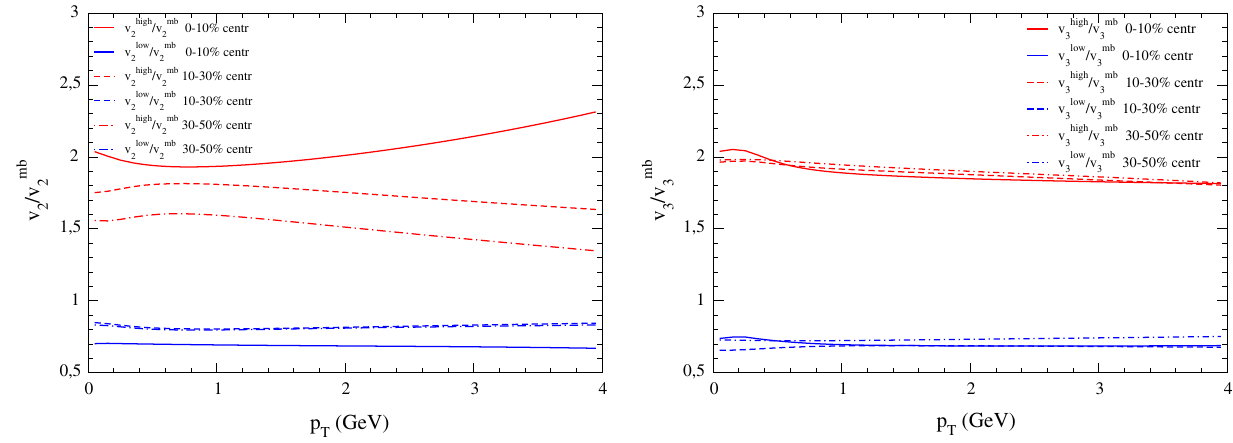
Fig. 6 Ratio of the charged-pion elliptic (left) and triangular (right) flow of high/low-eccentricity events over the minimum-bias ones within the same centrality class. Results of our hydrodynamic modelling can be compared to ALICE data from Ref. [28] Table 1 The ratios Centrality (cid:6) (cid:7) 2 (cid:7) high / (cid:6) (cid:7) 2 (cid:7) mb (cid:6) (cid:7) 2 (cid:7) low / (cid:6) (cid:7) 2 (cid:7) mb (cid:6) (cid:7) 3 (cid:7) high / (cid:6) (cid:7) 3 (cid:7) mb (cid:6) (cid:7) 3 (cid:7) low / (cid:6) (cid:7) 3 (cid:7) mb (cid:6) (cid:7) (cid:7) selected / (cid:6) (cid:7) (cid:7) unbiased obtained n n selecting, in the various centrality classes, the 0–20% and 0–60% most/least eccentric events